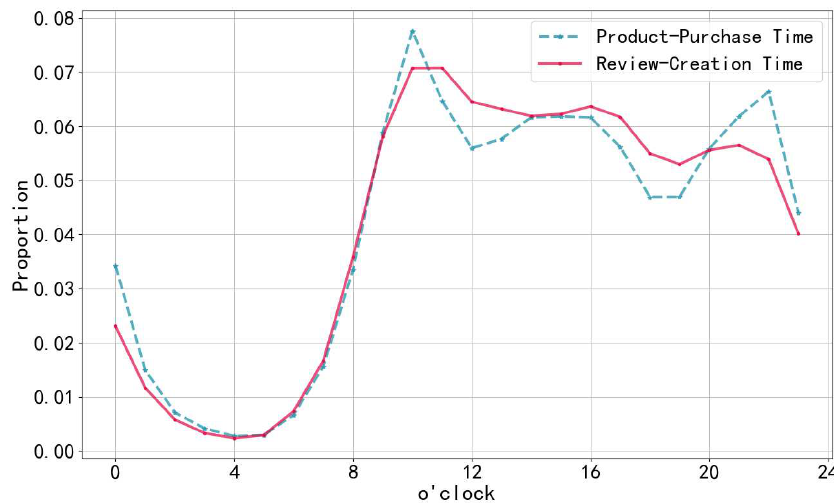
Figure A1. Distribution of review-creation time and product-purchase time on an hourly scale. All data represent negative reviews. All data represent negative reviews. The x -axis represents the hour, and the y -axis represents the proportion of consumers that purchase or post negative reviews at the corresponding hour.